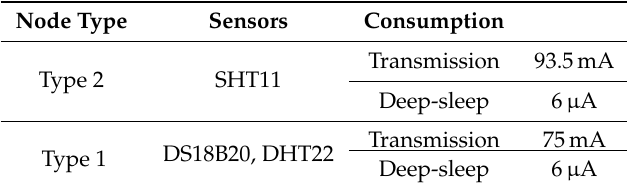
Table 4. Current consumption of each type of node during transmission and in deep-sleep mode.